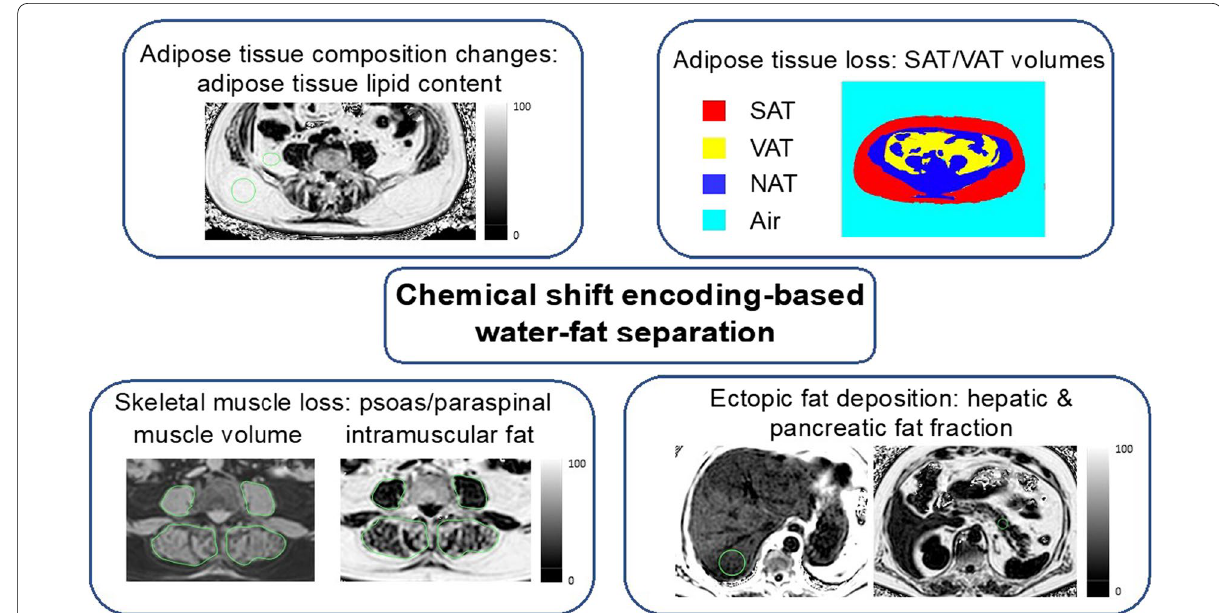
Fig. 2 Schematic showing the possible MRI biomarkers extracted from an abdominal chemical shift encoding-based water-fat separation MR imaging acquisition, including the determination SAT/VAT volume, ectopic lipid content in the liver and pancreas, paraspinal muscle volume and intramuscular fat content and adipose tissue lipid